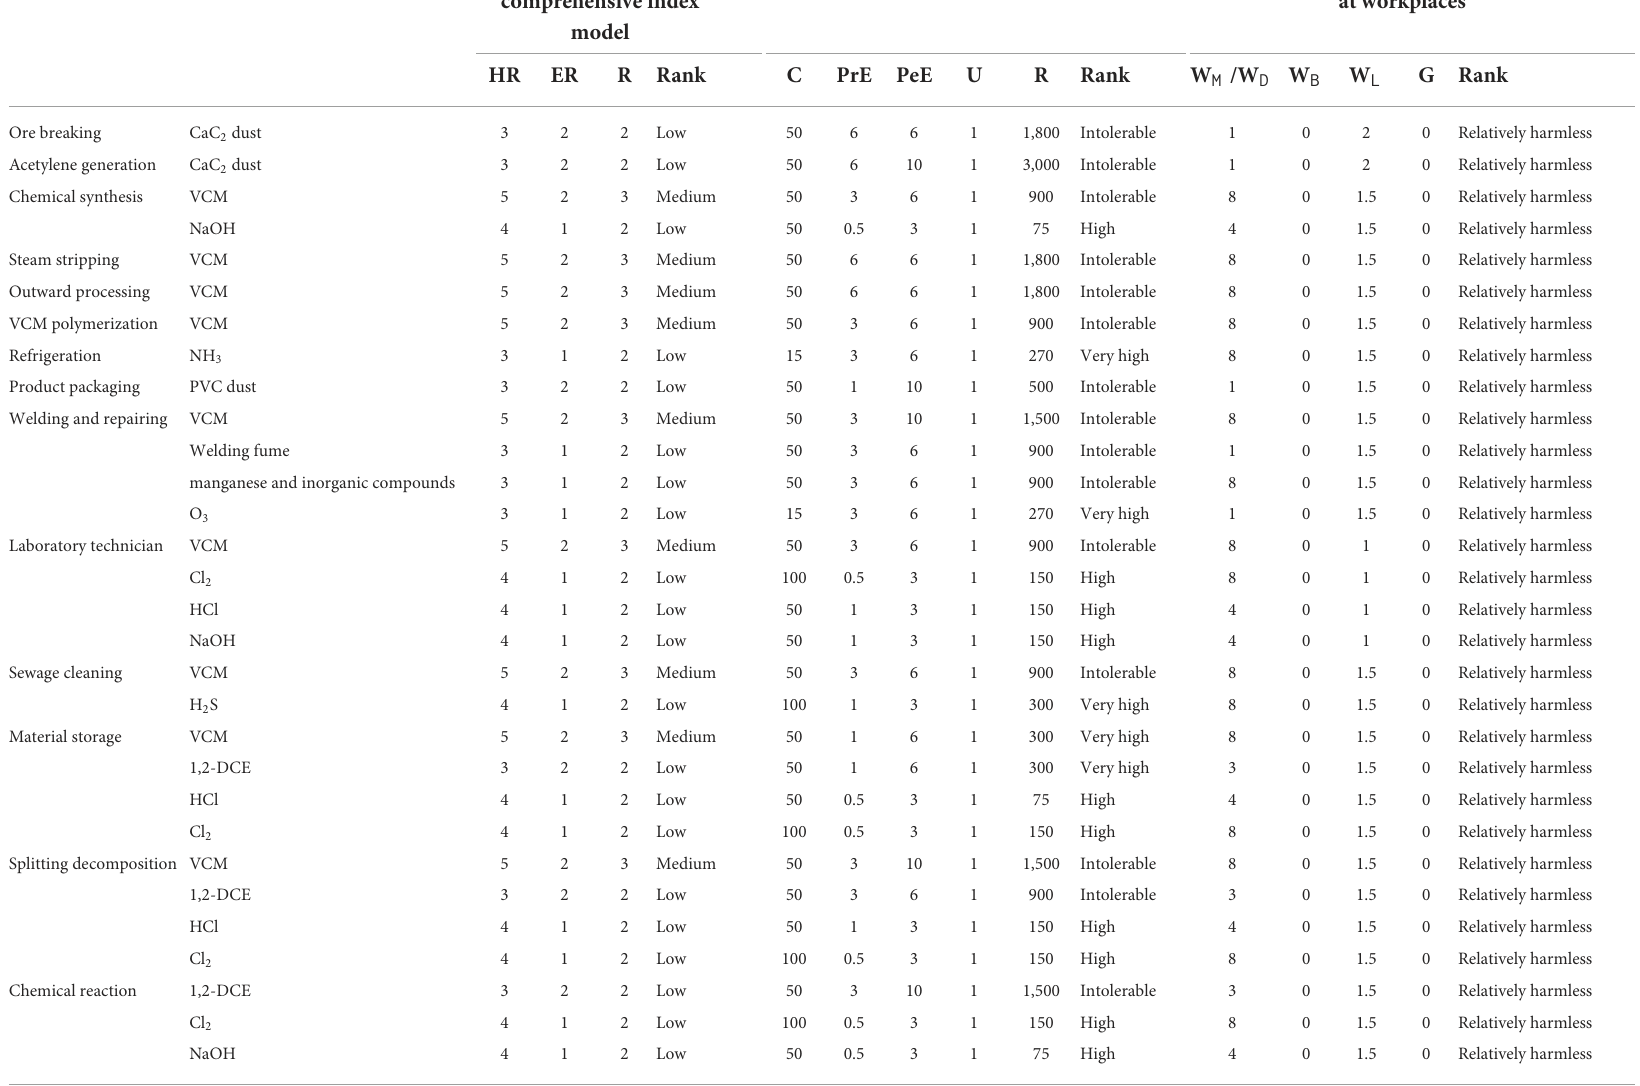
TABLE 7 Comparison results among three risk assessment models in 2021. Positions Hazards Semi-quantitative